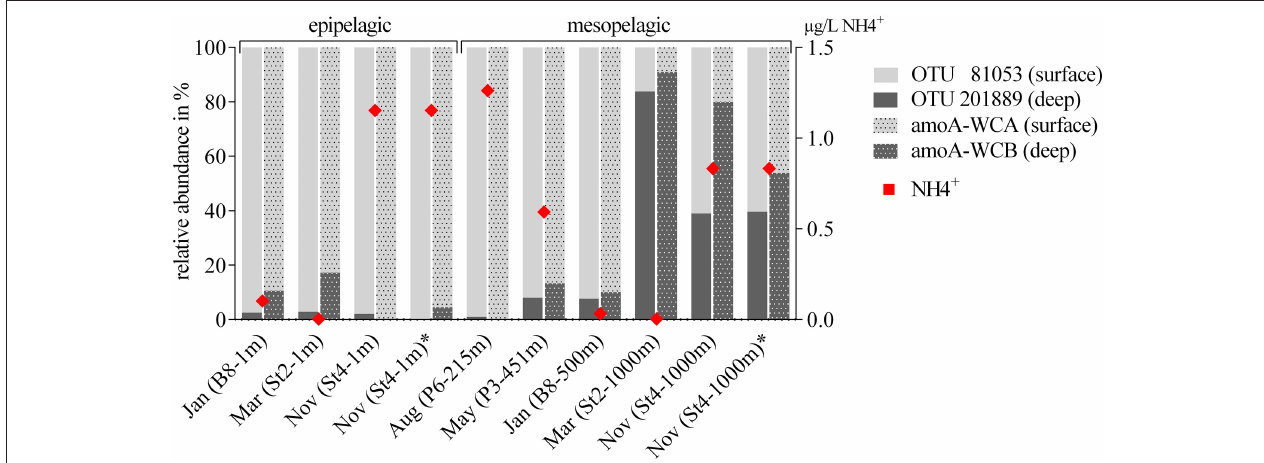
FIGURE 6 | Comparison of the relative abundance of Thaumarchaeota OTUs (16S rRNA gene) and the functional gene for ammonia oxidation ( amoA ). Thaumarchaeota OTUs are divided into the two most abundant sequences (OTU 81053 and OTU 201889), with highest relative abundance at the surface or the deep, respectively. amoA OTUs were divided into the two depth depending clusters WCA (surface) and WCB (deep). One station for each sampling month with a surface and deep sampling point were chosen (note, due to very low abundances, summer surface samples are not included), including all five water masses encountered during the five cruises. Ammonium concentrations at each sampling point are visualized as red diamonds (0 = below the detection